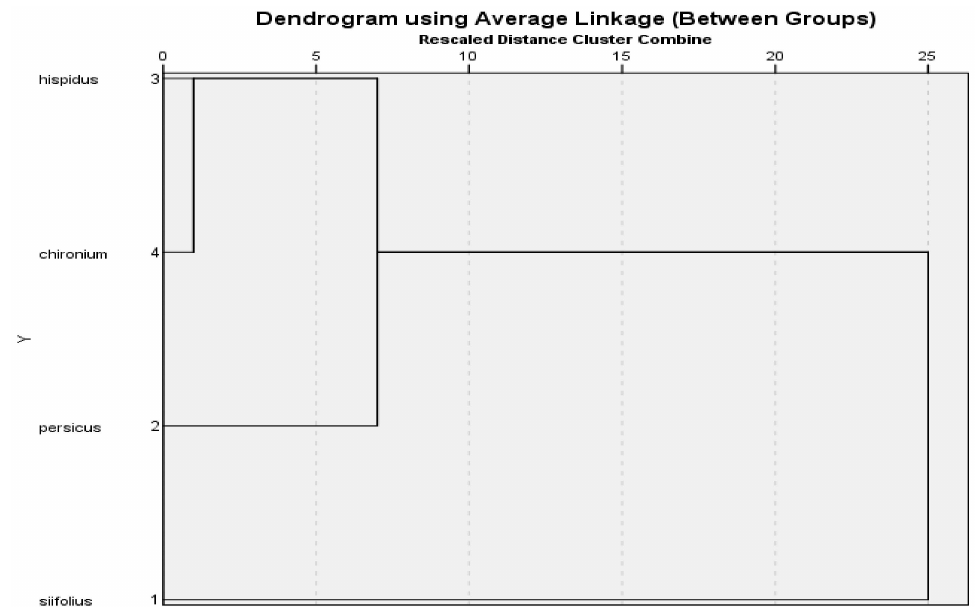
Figure 1. Clustering analysis of the Opopanax genus according to oil volatile components.